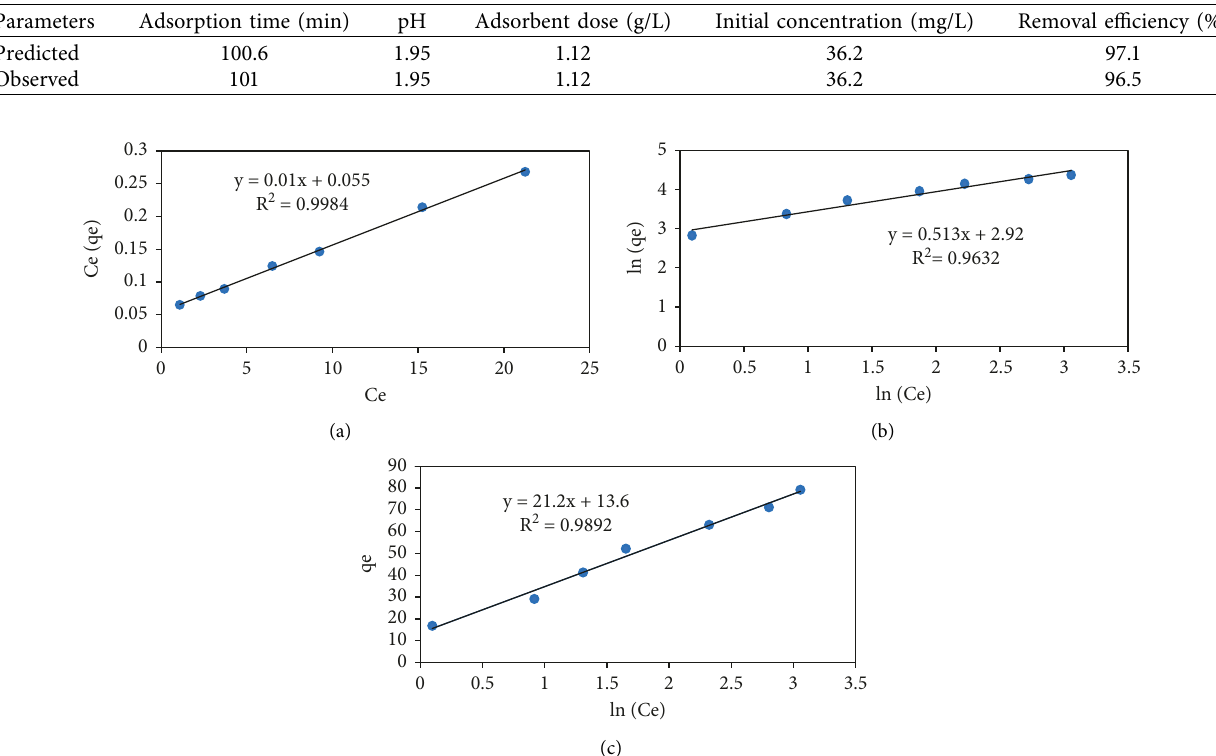
Table 7: Model predicted and experimental responses at optimum conditions.